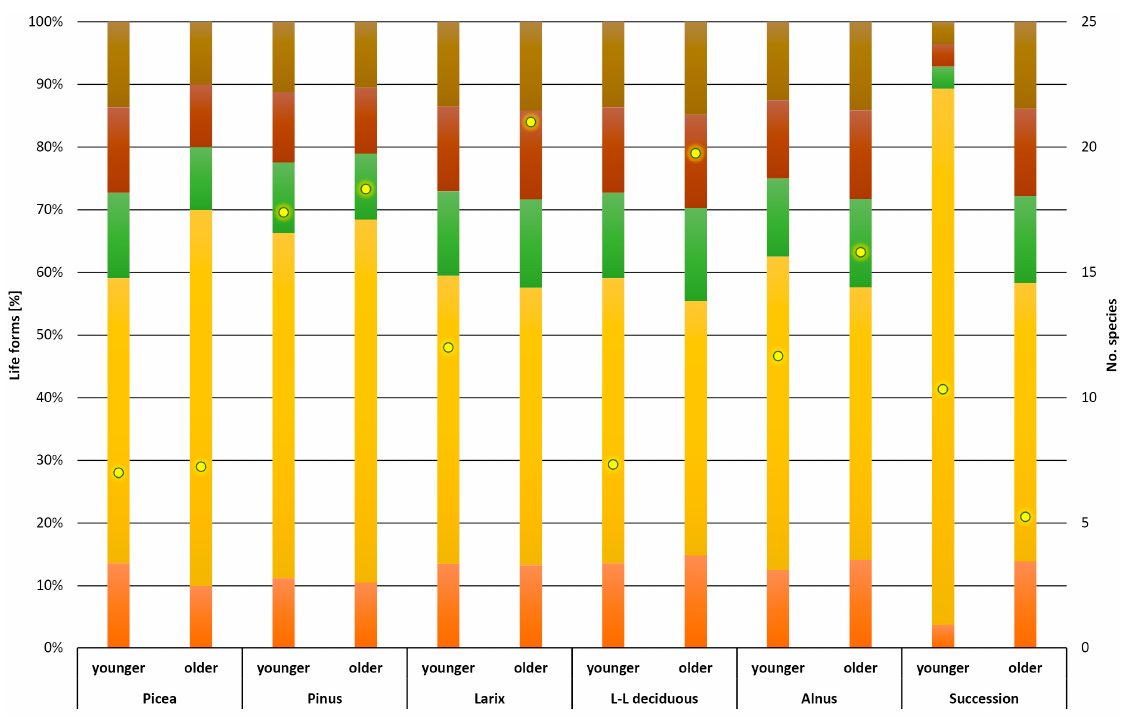
Figure 3. Raunkiær's life forms—distribution of functional groups in forest type and different ages. NF—nanophanerophyte, HF—hemicryptophyte, G—geophyte, T—therophyte, MF—macrophan-